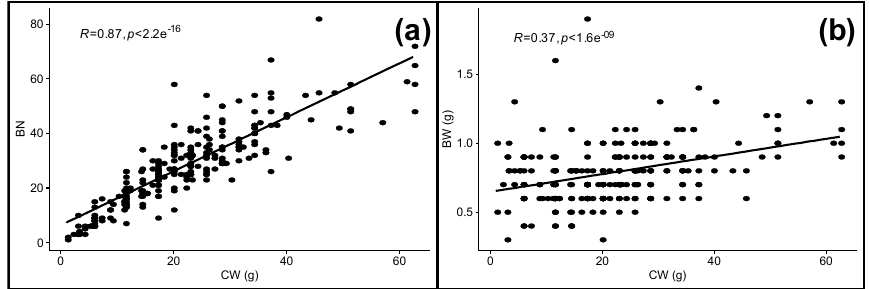
Figure 3. Pearson correlation of cluster weight (CW) and its determinants: ( a ) berry number (BN) and ( b ) berry weight (BW).